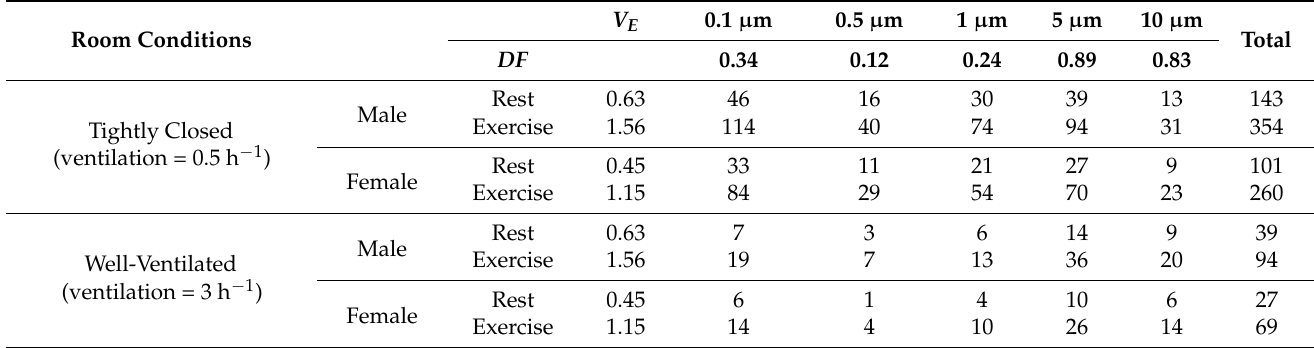
Table 2. Dose rate (viruses/hour) as a function of the particle diameter ( µ m), room conditions, human gender, and physical activity for the exposure levels illustrated in Figure 1b,c. Here, V E (m 3 /h) is the minute ventilation (volume of air breathed) and DF is the deposition fraction in the respiratory